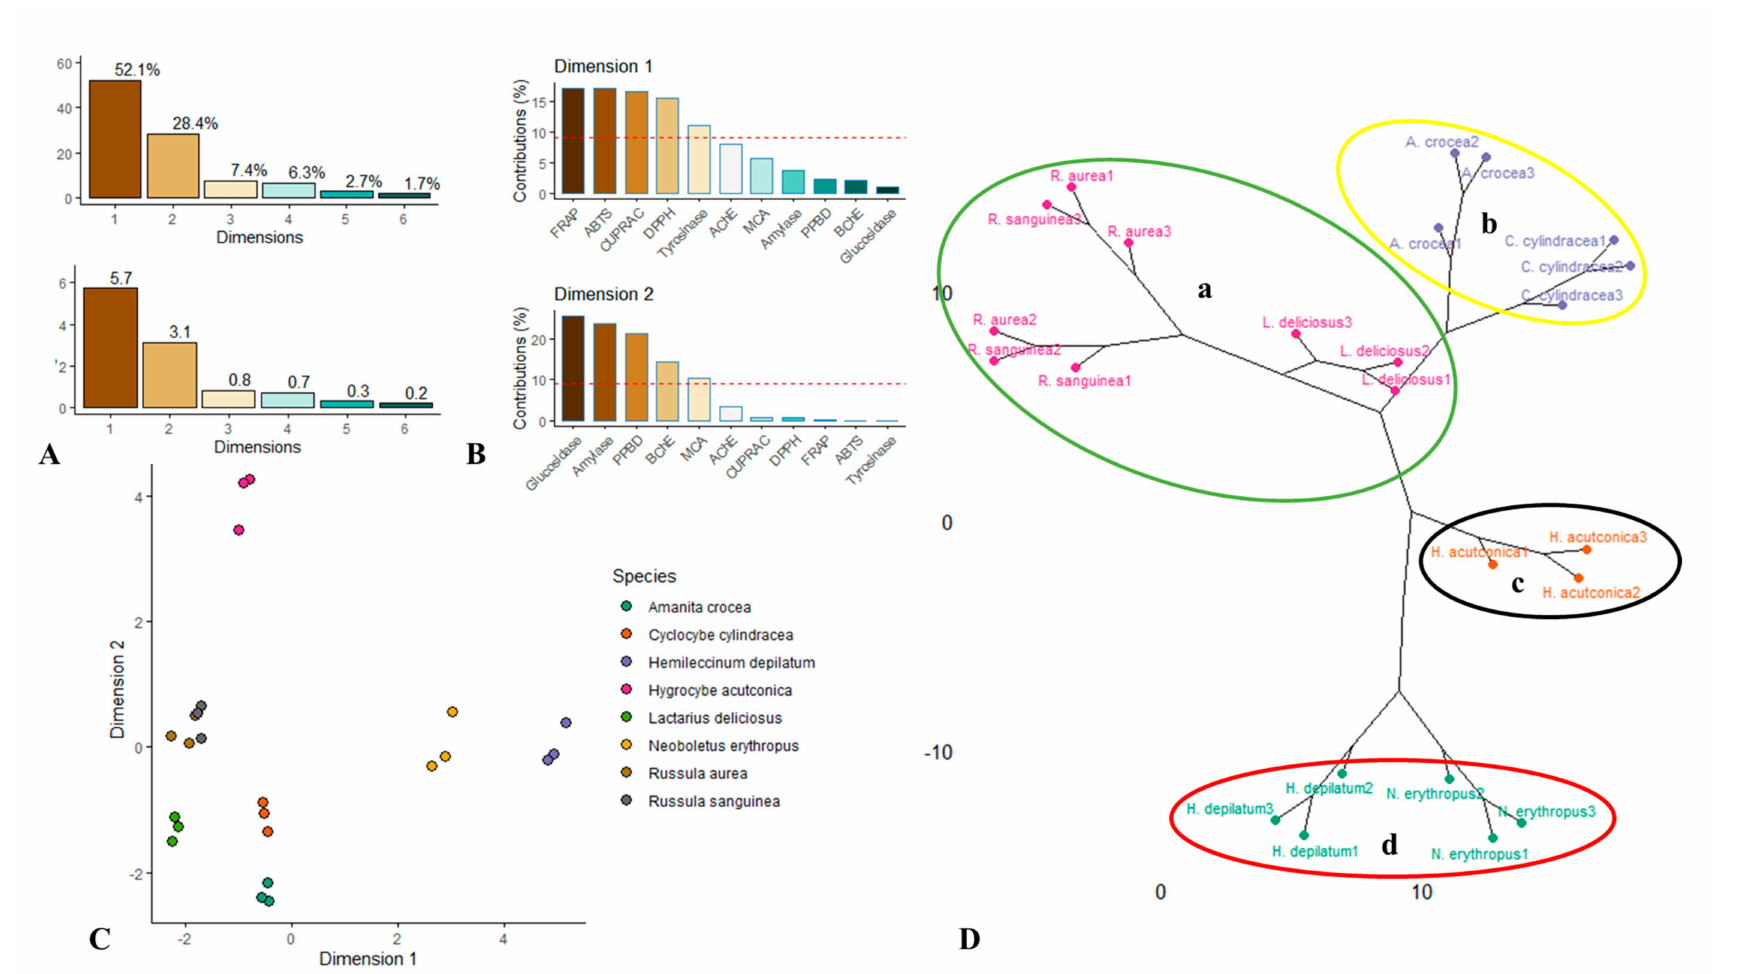
Figure 1. Principal component (PCA) and cluster analyses of bioactivities of mushroom species. ( A ) Percentage of explained variance and eigenvalue of dimensions of PCA; ( B ). contribution of bioactivities on the first two dimensions of PCA; ( C ) score plot of Dim 1 vs. Dim 2; ( D ) clustering of the species